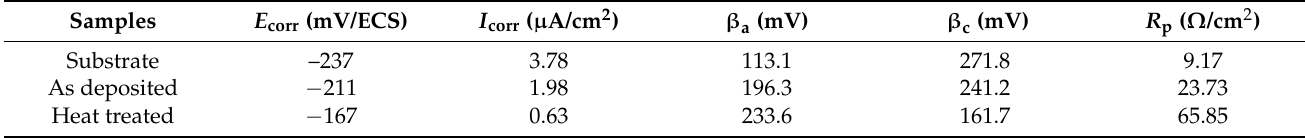
Table 2. Polarization parameters obtained from Tafel